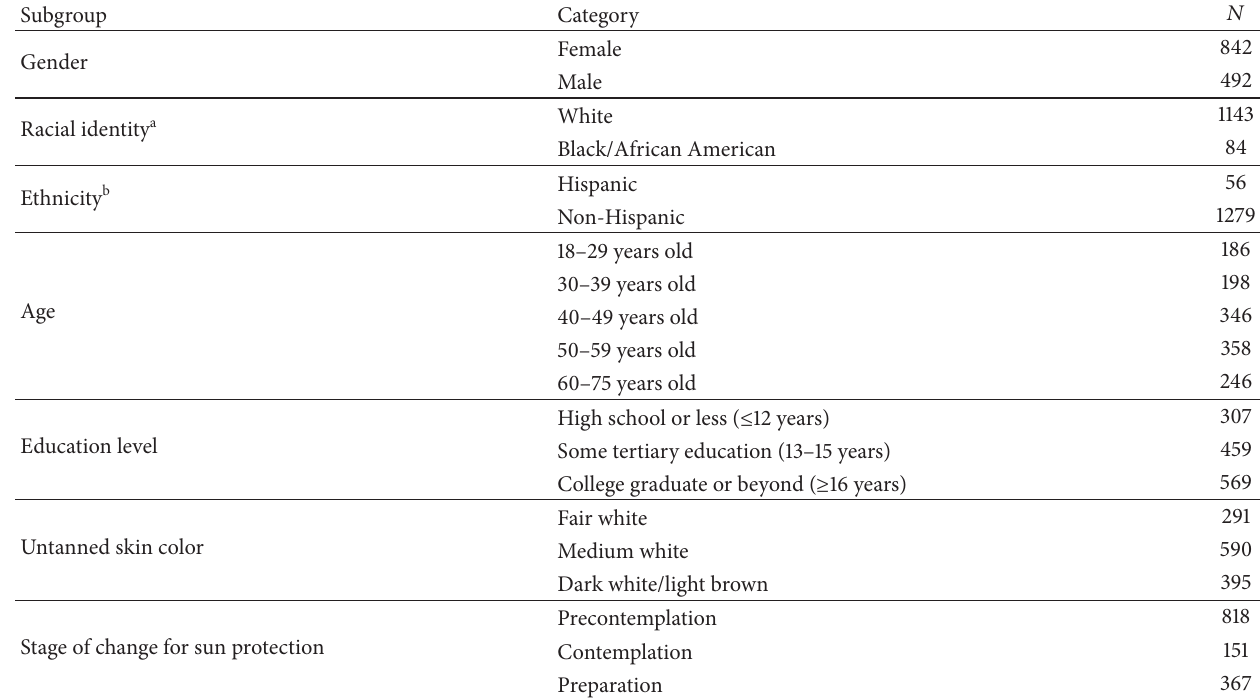
Table 1: Sample size by category for each